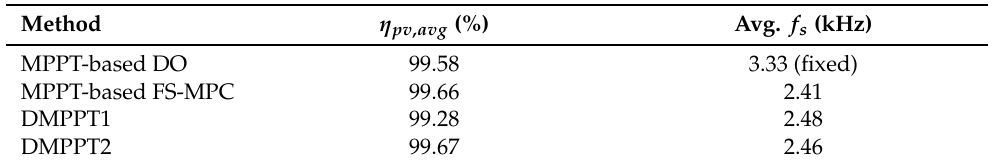
Table 6. The average efficiency and average switching frequency for the MPPT algorithms at dynamic radiation